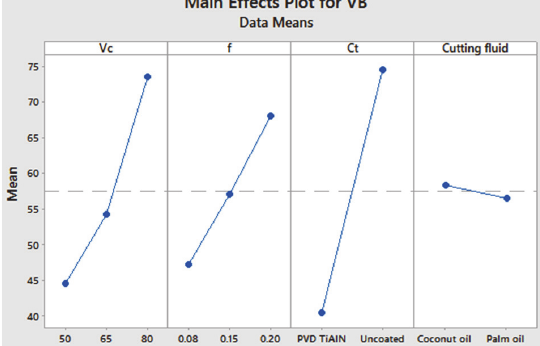
Fig. 10. Main effect plot for Flank wear, VB